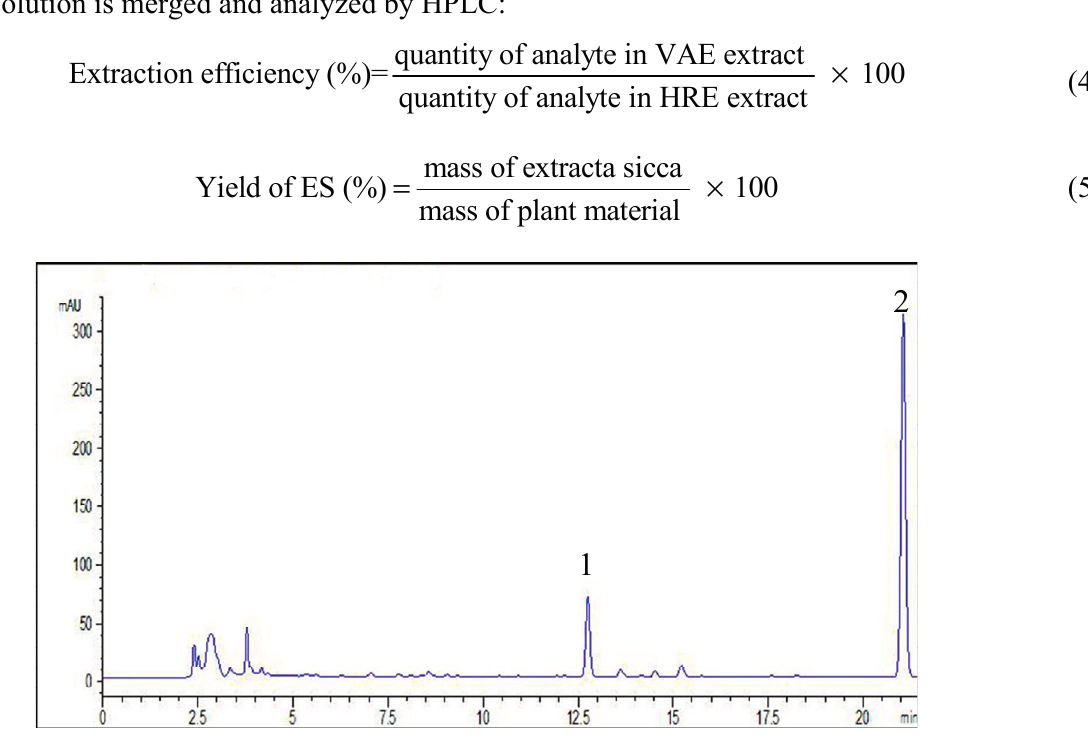
Figure 6. HPLC chromatograms of diterpenoids from A. paniculata . Peak 1, andrographolide (AP 1 ) and peak 2, dehydroandrographolide (AP 3